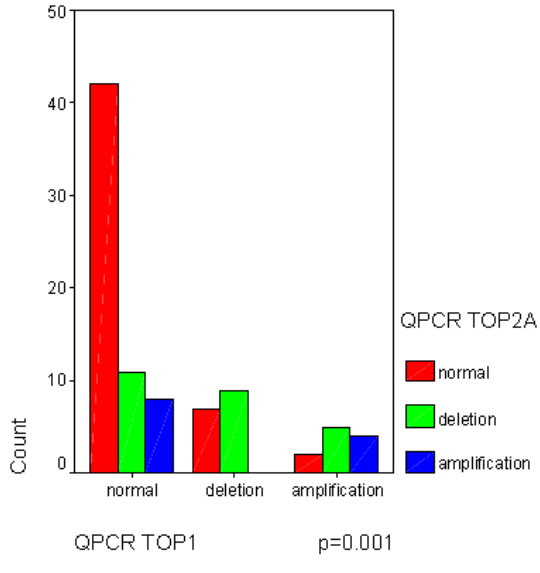
Figure 3. The significant correlation between TOP1 and TOP2B gene copy